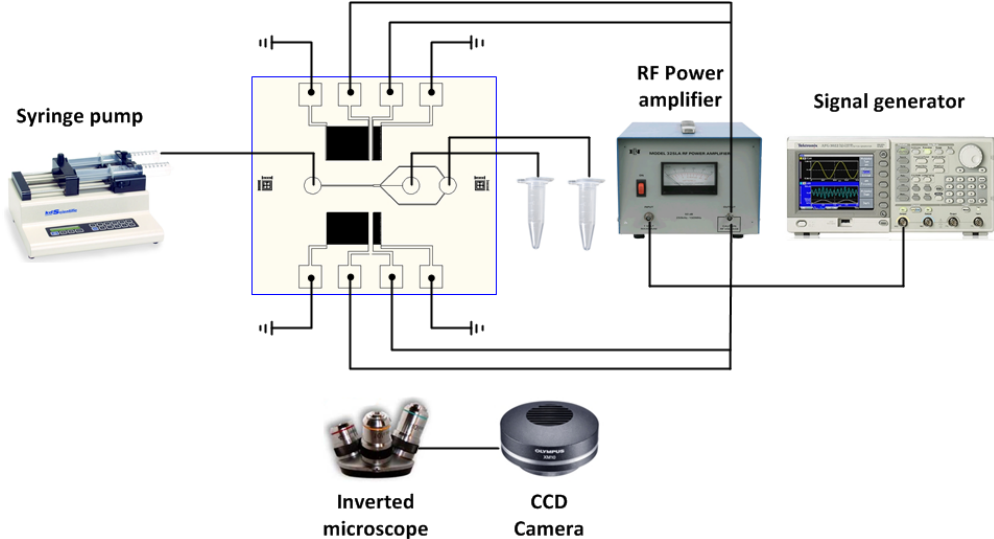
Figure 7. Experimental setup for the sheathless acoustic particle